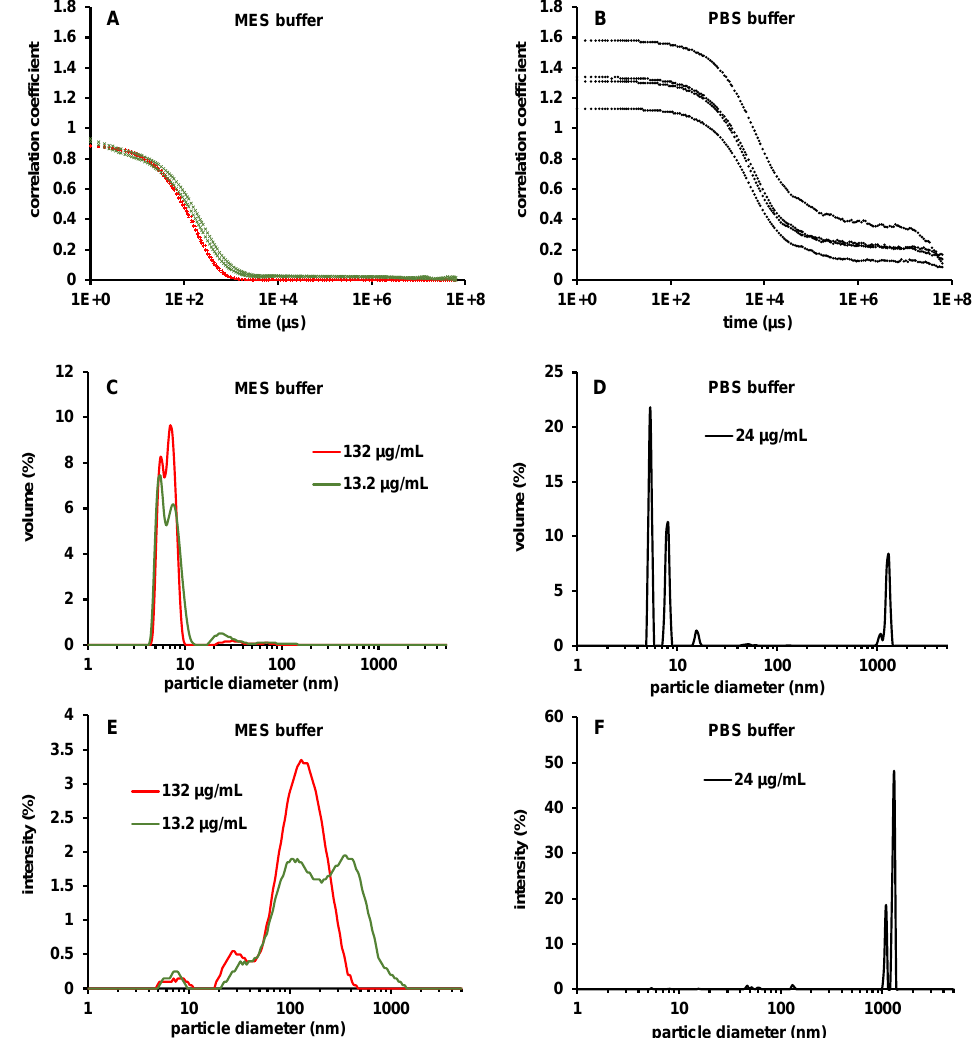
Figure 11. Autocorrelation functions of dynamic light scattering (DLS) measurements of BMP-2 in ( A ) MES buffer and ( B ) PBS buffer. ( C ) DLS size distribution of BMP-2 in MES buffer pH 5 by volume and ( E ) by intensity and ( D ) DLS size distribution of BMP-2 in PBS pH 7.2 by volume and ( F ) by intensity.